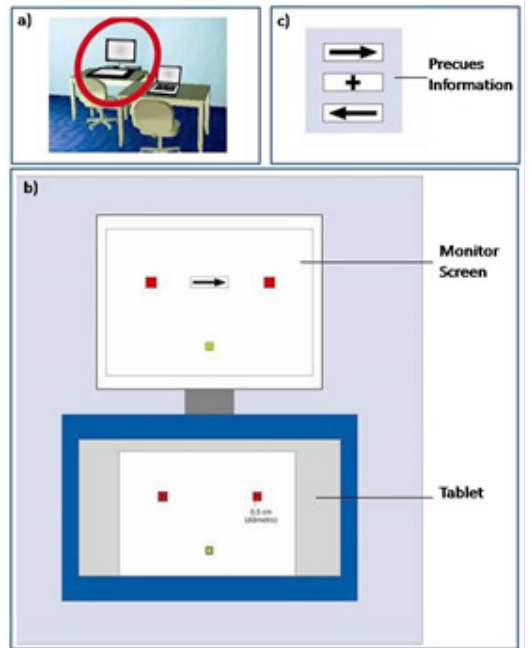
Figure 1. (a) Illustration of the experimental setup. Highlight: Table containing the tablet and monitor; (b) illustration of the experimental marks and targets on the monitor and tablet; and (c) types of pre-cue information (arrows), indicating the side where the imperative stimu- lus (red square) or not (plus sign)